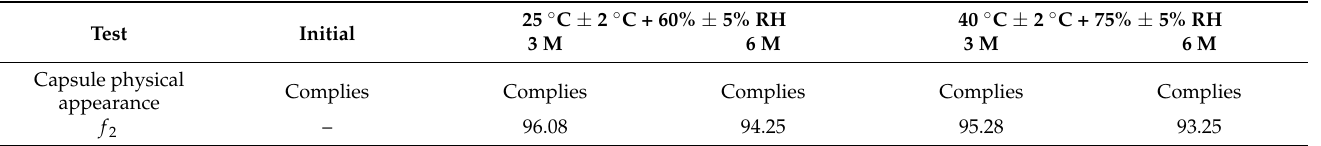
Table 7. Stability studies for tablet in capsule